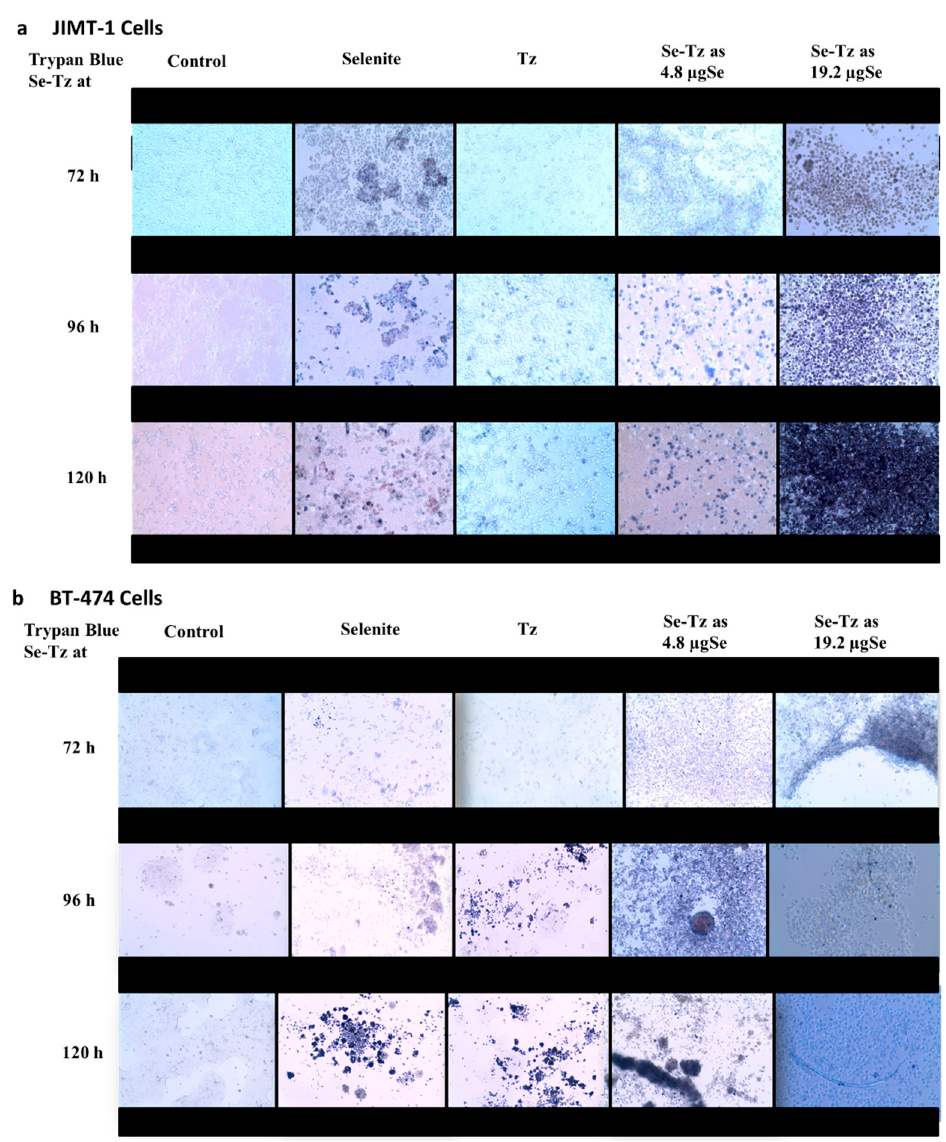
Figure 4. 20X Microphotographs of Trypan Blue Stained Cells after Treatments. ( a ) JIMT-1 cells photographed at the concentrations and times indicated; ( b ) BT-474 cells photographed at the concentrations and times indicated. Selenite was used as a redox toxic positive control at a concentration of 10 µ gSe/well. Selenite at concentrations less than 10 µ gSe/well had no visible effect on cancer cell lines under these experimental conditions.